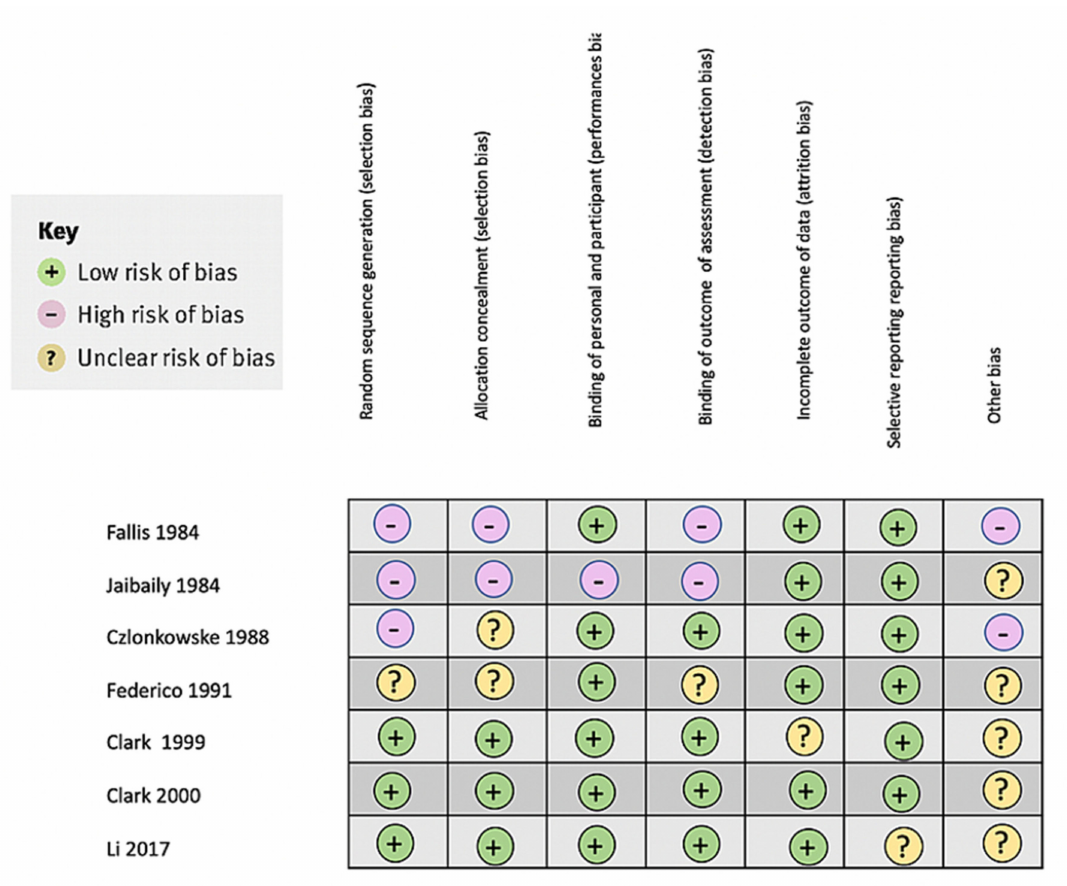
Figure 2. Bias analysis of the systematic review of the